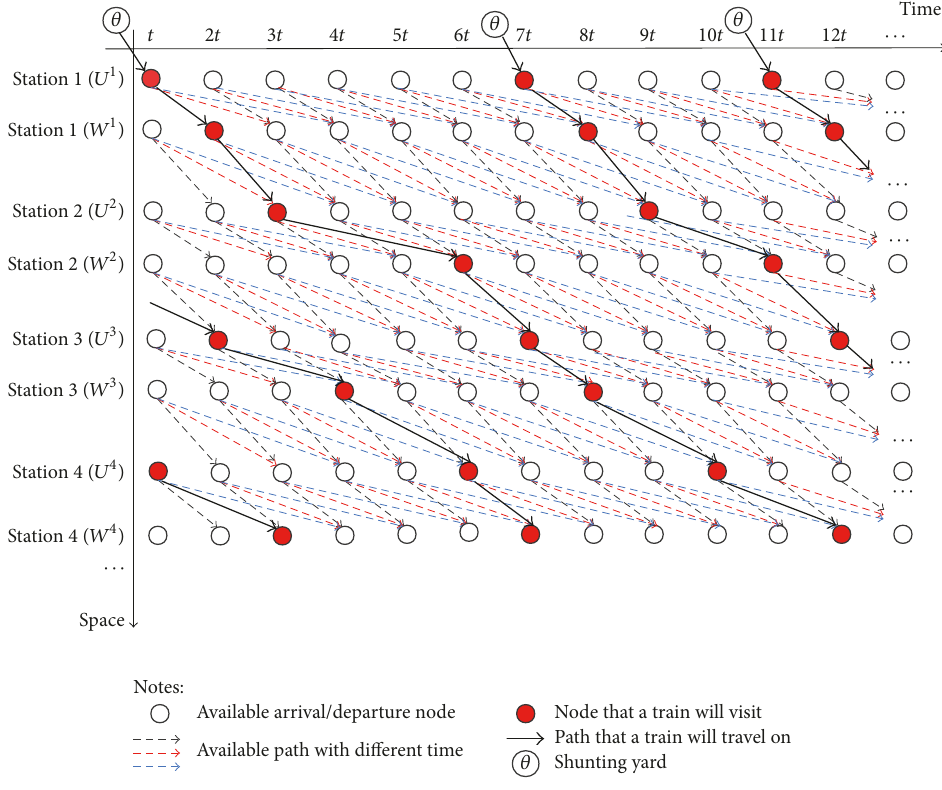
Figure 2: Representation of discrete time-space